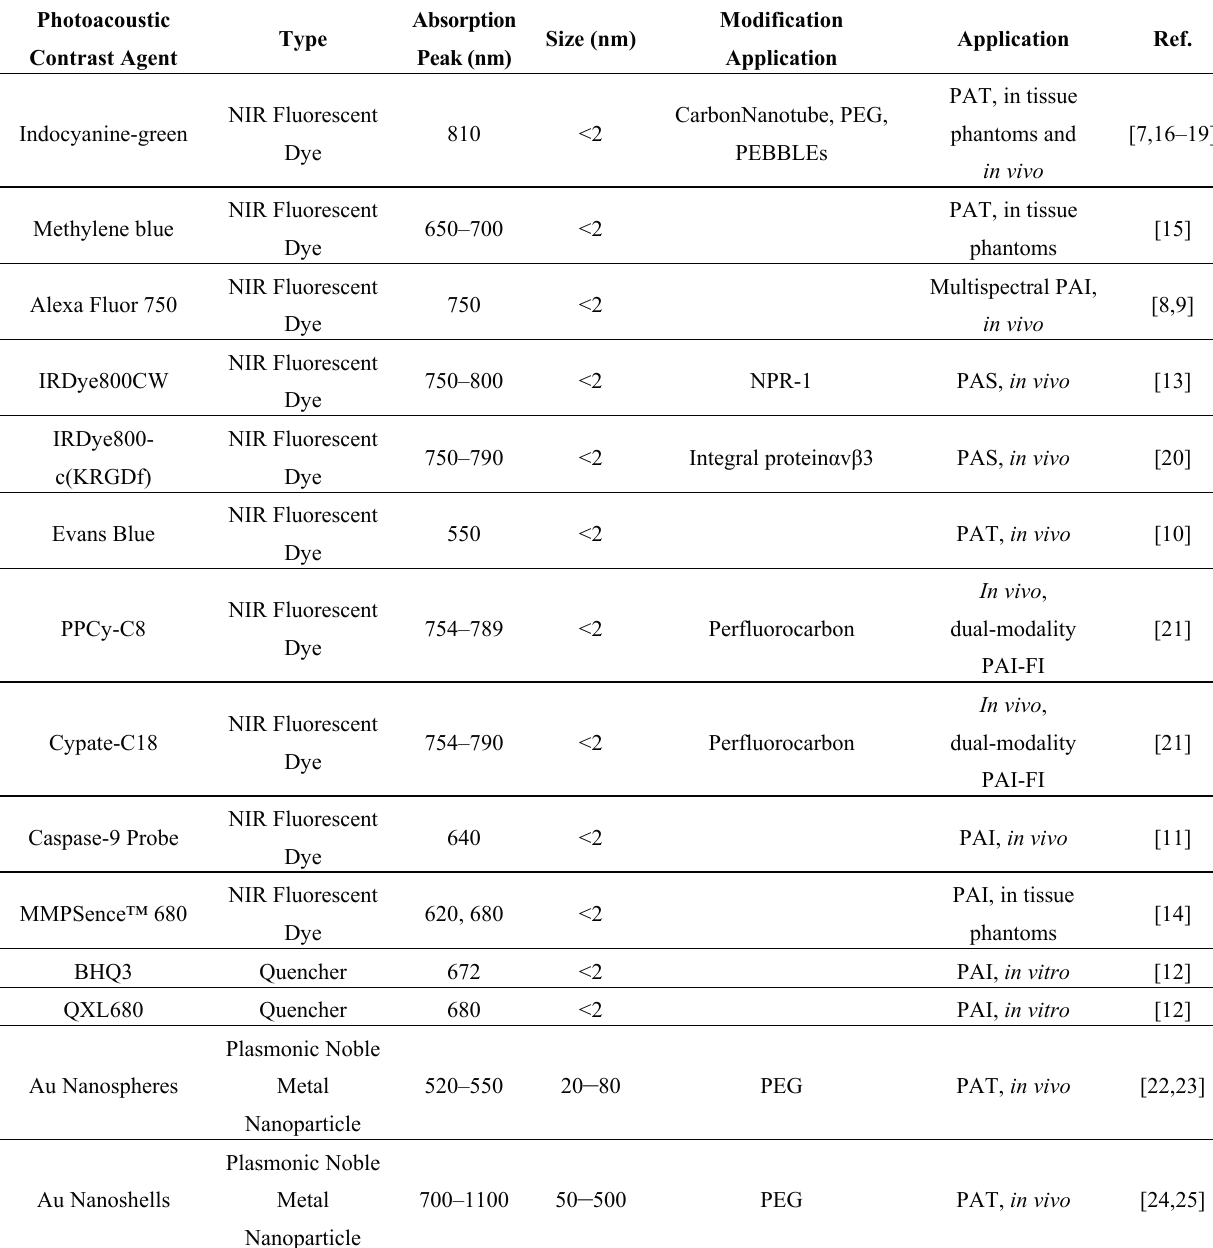
Table 1. Contrast agents for photoacoustic